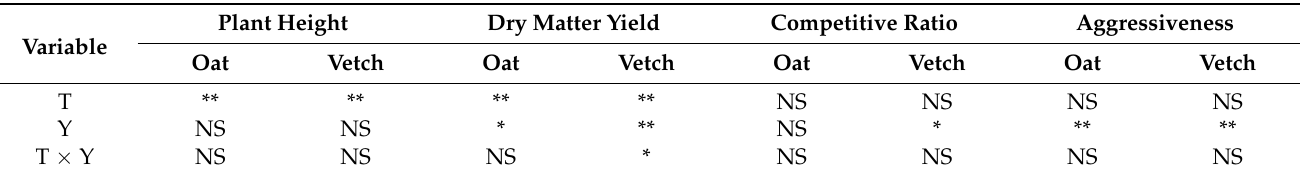
Table 2. ANOVA for the effects of treatments (T), years (Y), and their interactions (T × Y) on plant height, dry matter yield, competitive ratio, and aggressiveness.